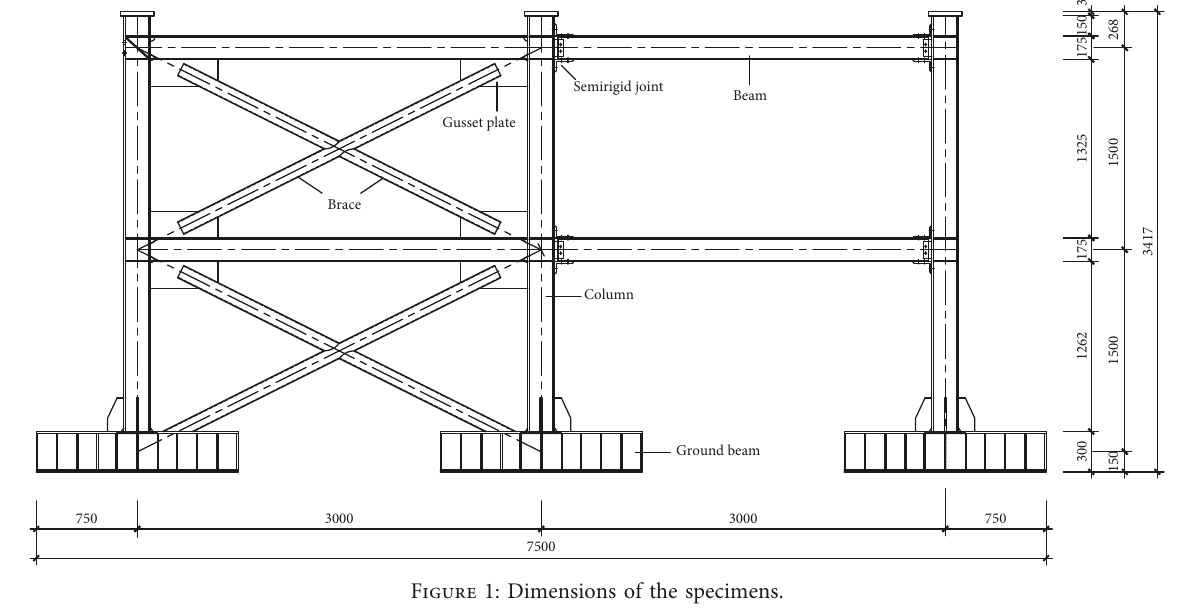
Figure 1: Dimensions of the specimens.